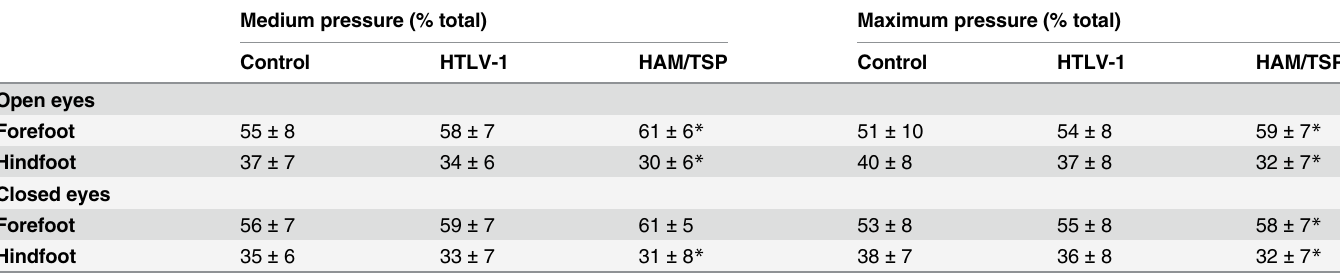
Table 2. Mean medium and maximum pressure values in different foot